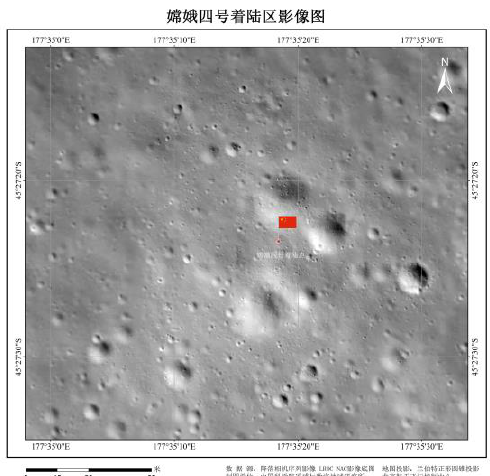
Figure 9. CE-4 landing site DOM generated from descent images.